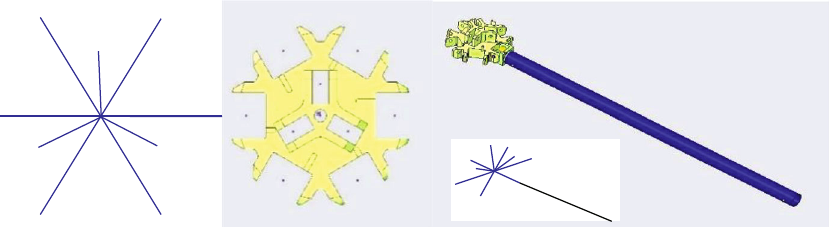
Figure 2: Rod deformation and disc chuck.